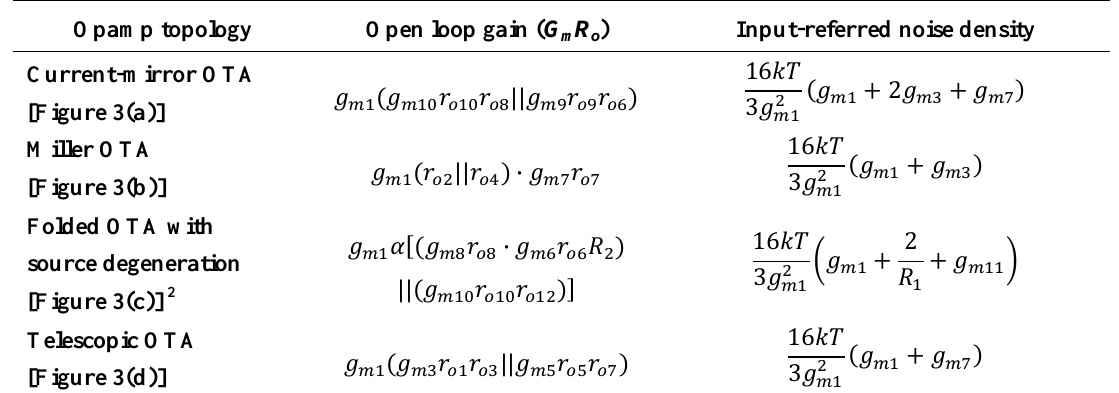
Table 2. Summary of Low-Noise OTA Parameters 1